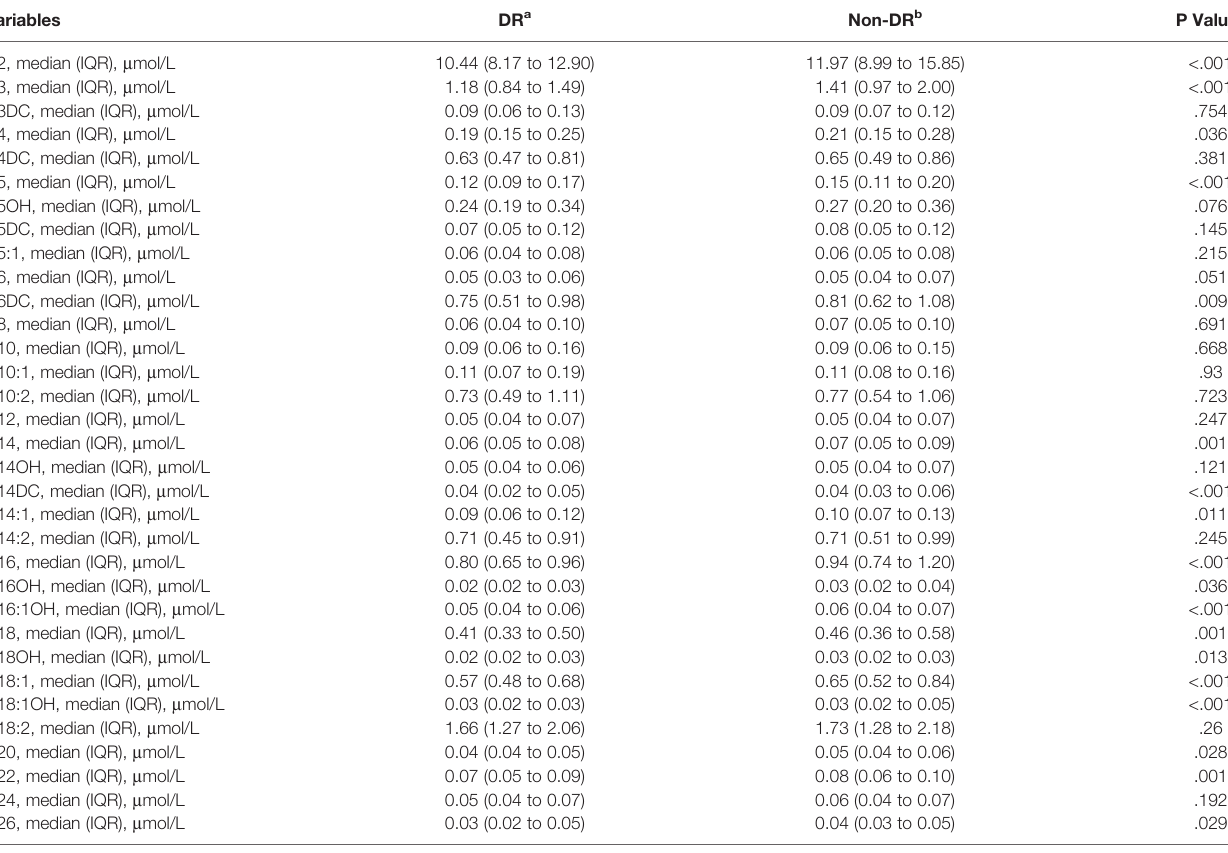
TABLE 2 | Acylcarnitine pro fi le in T2DM patients.